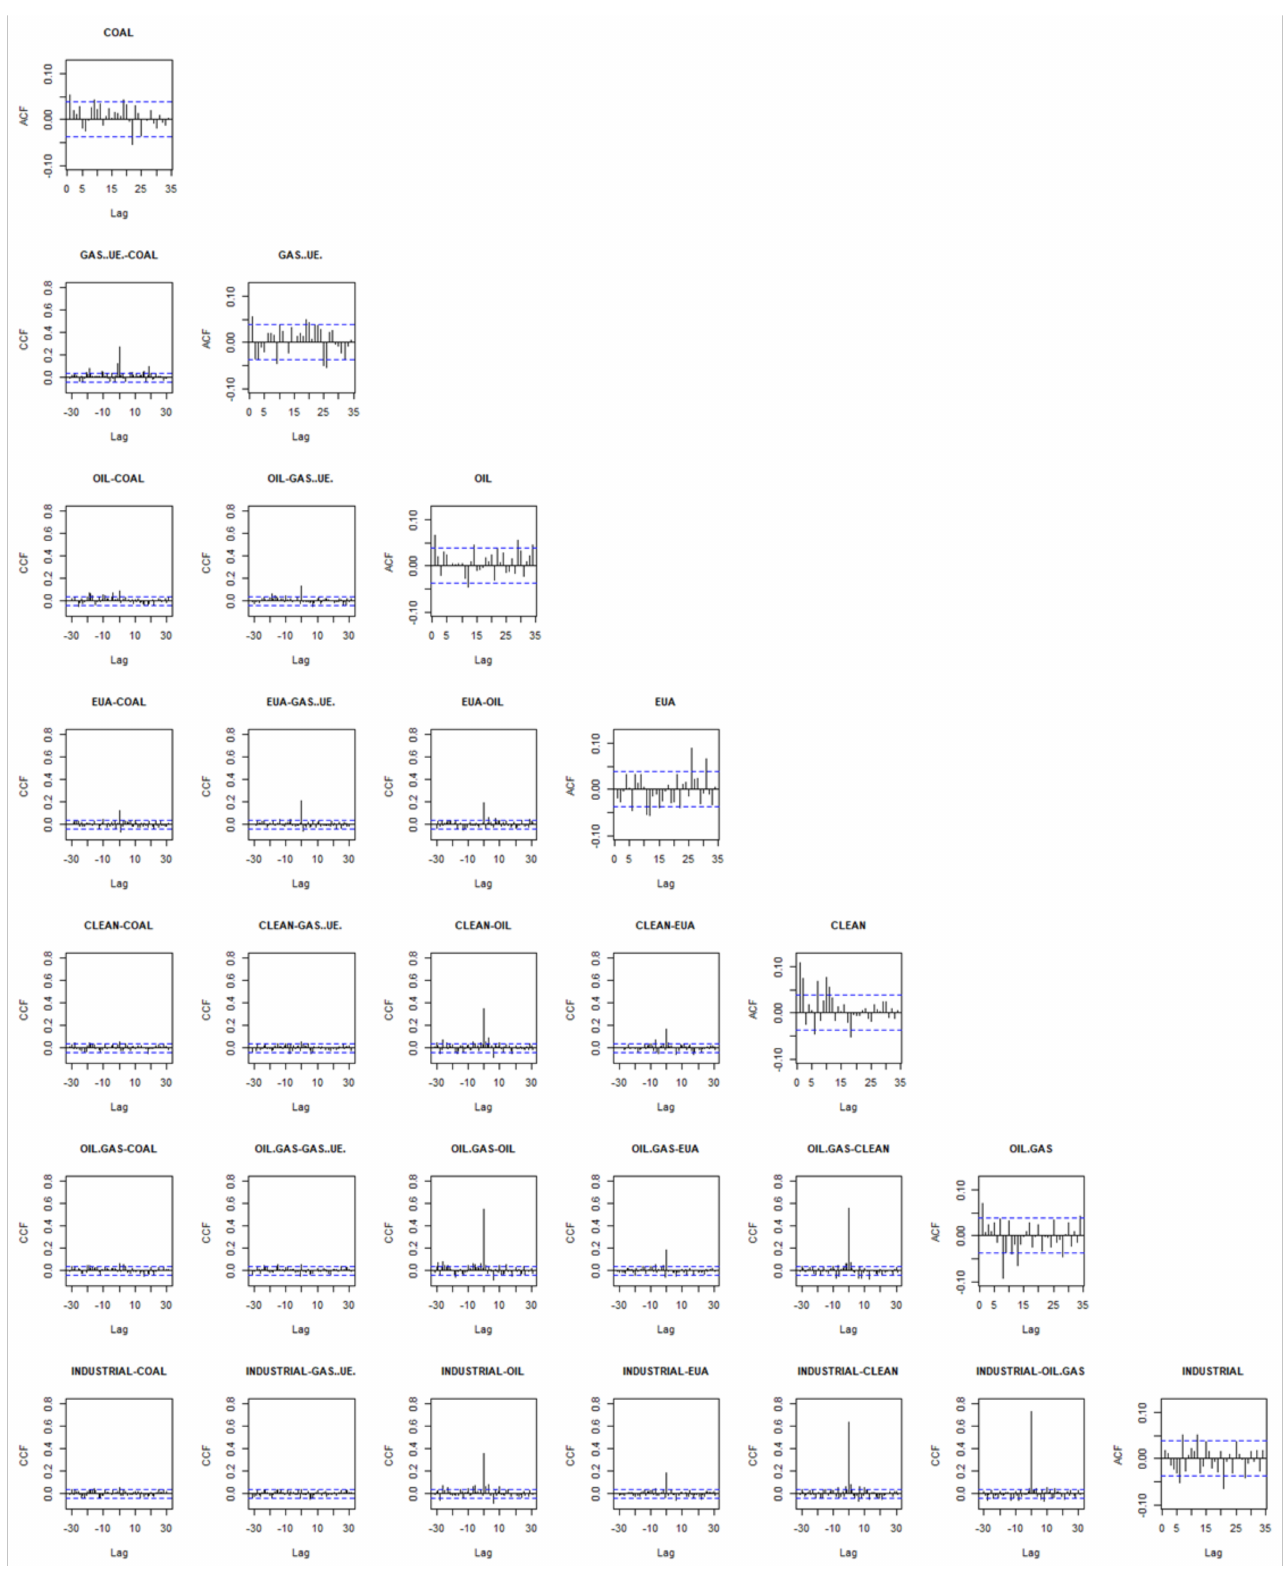
Figure 3. Cross-correlation function of the returns of the seven series in the off-diagonal cells and with the autocorrelation function on themselves in the